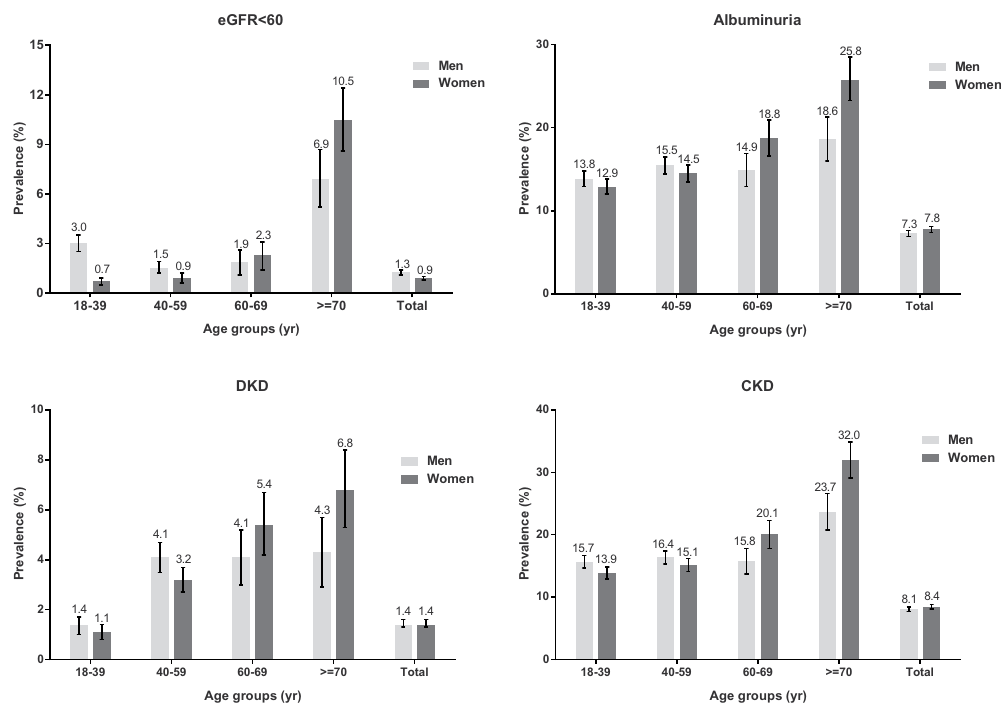
Figure 1. Adjusted prevalence of indicators of renal damage, diabetic kidney disease and chronic kidney disease, stratified by sex and age. Chronic kidney disease was defined as eGFR less than 60 mL/min/1.73 m 2 or presence of albuminuria. Diabetic kidney disease defined as participants with diabetes and one or two indicators of renal damage. Bars were 95% confidence interval. CKD = chronic kidney disease, DKD = diabetic kidney disease, eGFR = estimated glomerular filtration